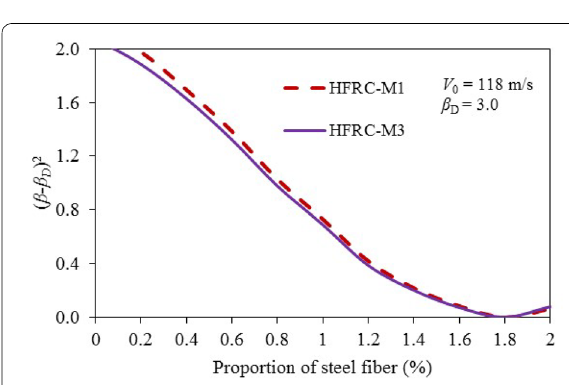
Fig. 8 Effect of steel fiber percentage on reliability of HFRC slab specimens.